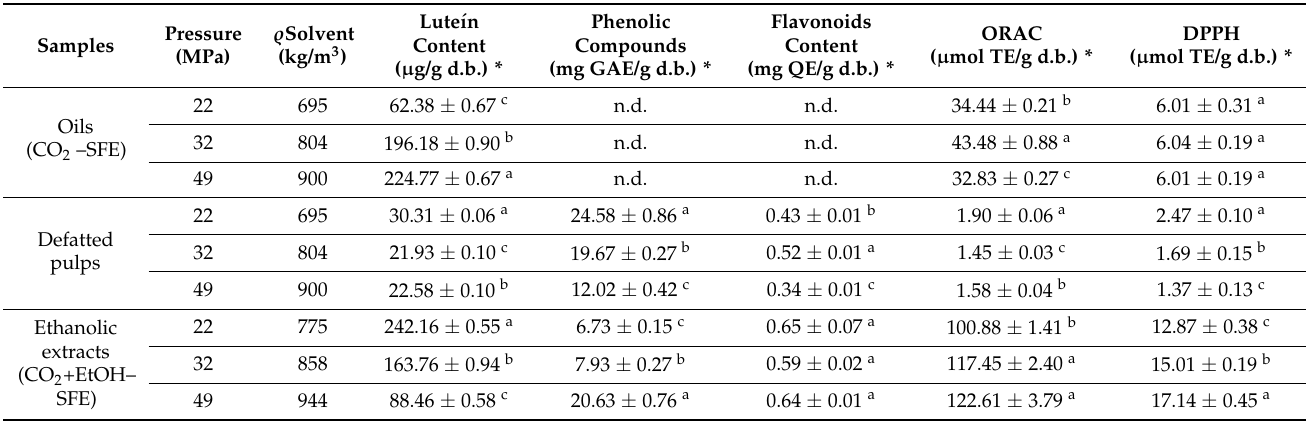
Table 1. Operating conditions of CO 2 –SFE and CO 2 +EtOH–SFE of murici pulp ( B. crassifolia ) and characterization of the different defatted pulps and